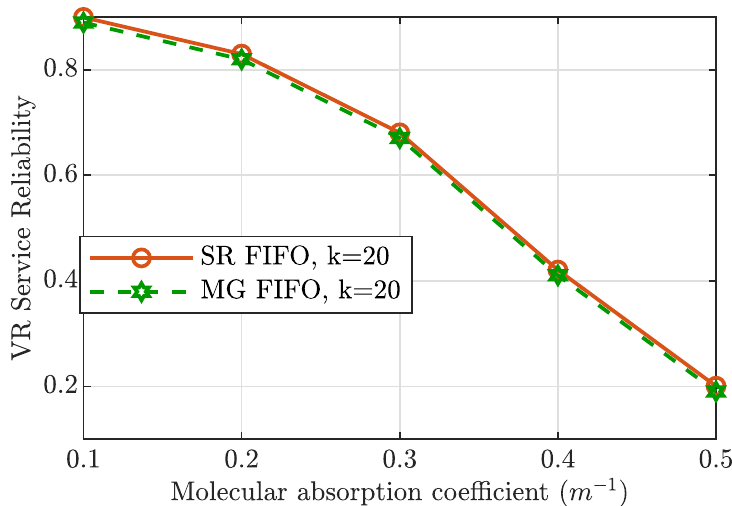
Figure 5. Reliability as a function of the molecular absorption, considering p H , p G = 0.01, and p c , p d = 0.012.